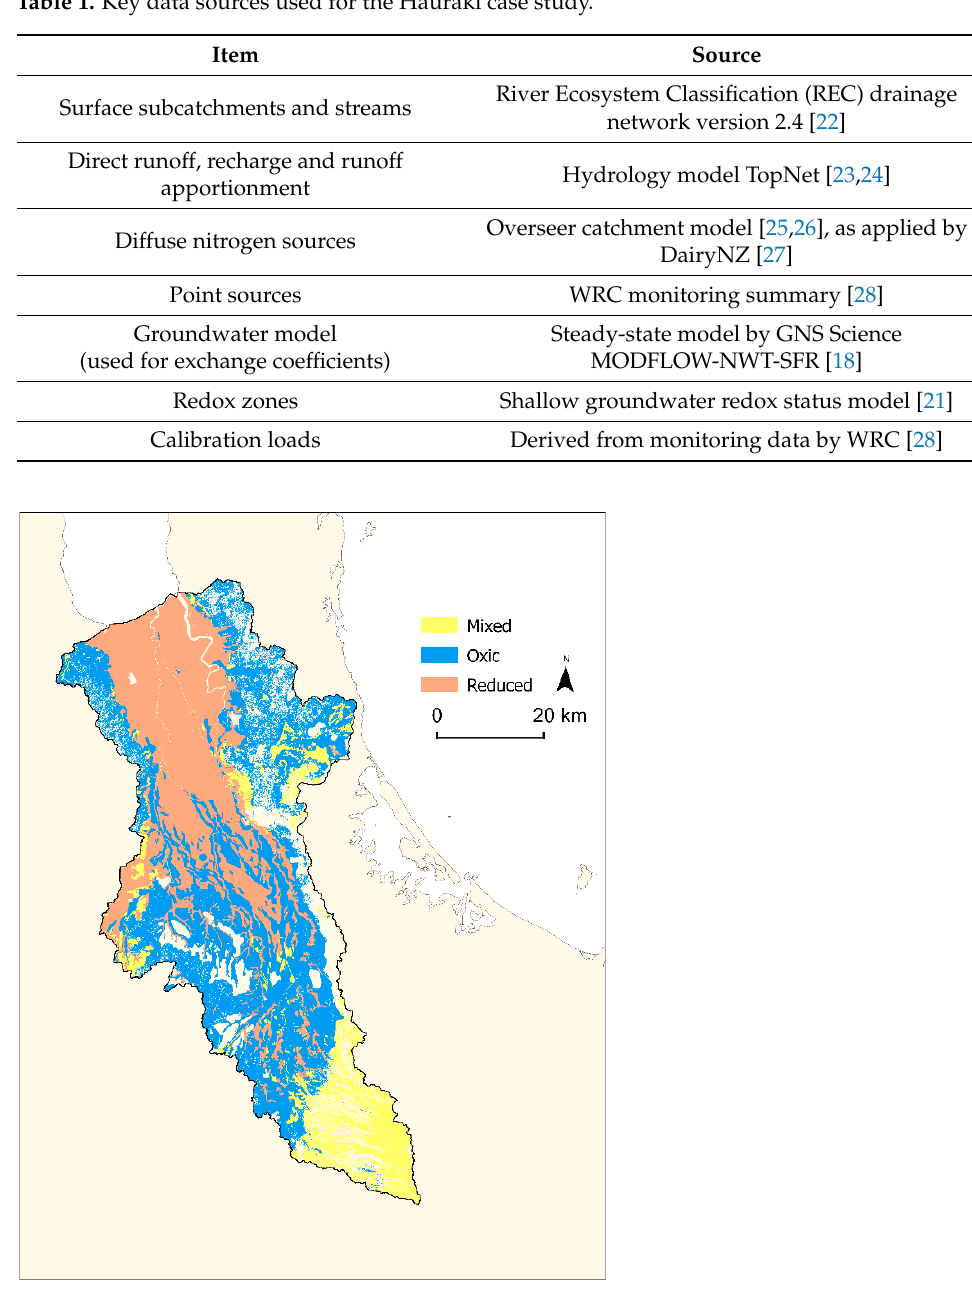
Figure 4. Map of groundwater oxic classes for the Hauraki [21] .